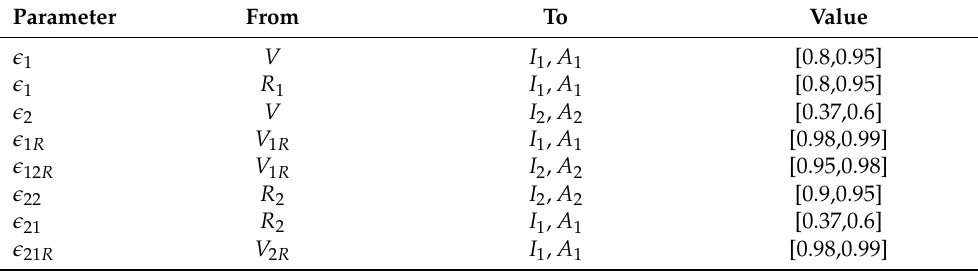
Table 2. Values of the assumed efficacies for the SARS-CoV-2 vaccines used in the in silico simulations. Parameter From To